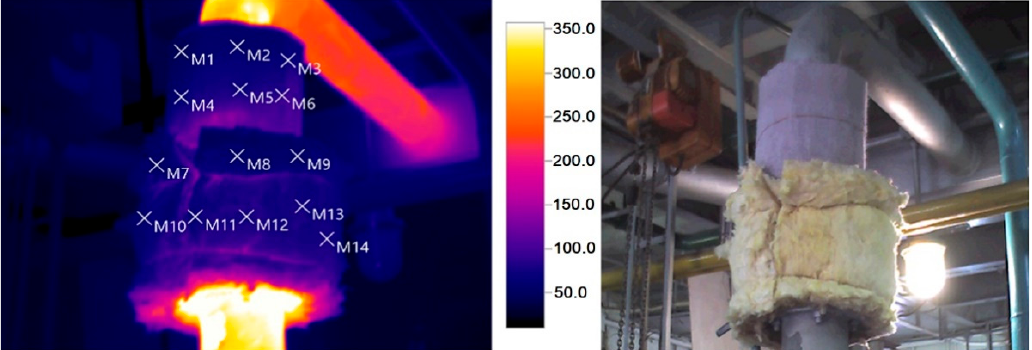
Figure 4. Thermal imaging of an insulated chimney at 600 °C, measurements (°C): M1—47.5; M2—59.6; M3—72.0; M4—63.9; M5—76.2; M6—81.2; M7—54.0; M8—58.1; M9—56.8; M10—61.1; M11—